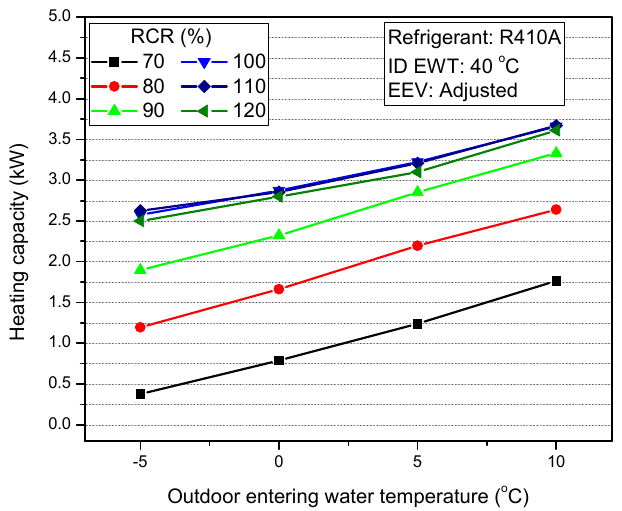
Figure 18. Heating capacity with variation of T OD in heating mode.